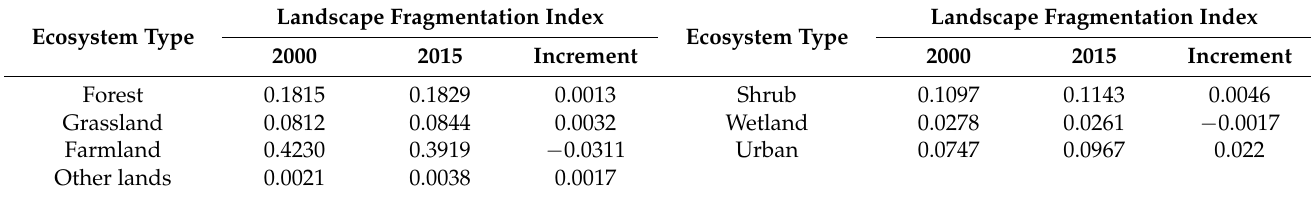
Table 4. Fragmentation and changes in ecosystem patterns of the Beijing–Tianjin–Hebei urban agglomeration from 2000 to